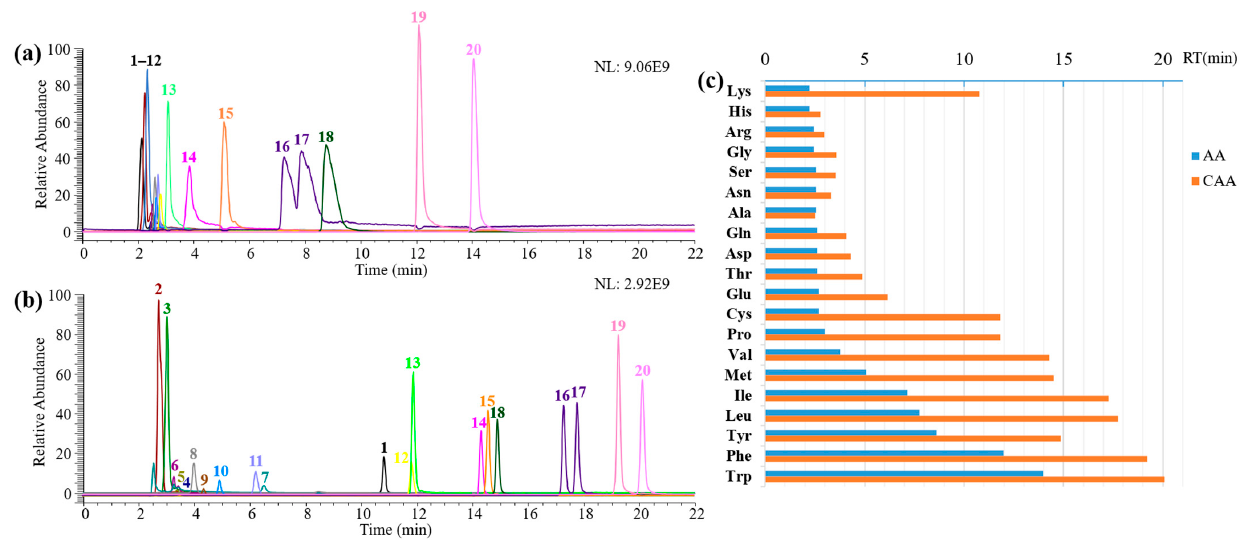
Figure 3. Derivatization of 20 AA Mixtures. ( a ) EIC-MS profile of 20 AAs. ( b ) EIC-MS profile of 20 CAAs. Unmarked peaks are unreacted AA and unidentified derivatization byproducts. ( c ) Changes in AA retention time on reversed-phase C18 column before and after derivatization: orange (AA) and blue (CAA). The abscissa is the retention time in minutes, and the ordinate is the AA. AAs are marked with numbers as follows, 1: Lys, 2: His, 3: Arg, 4: Gly, 5: Ser, 6: Asn, 7: Ala,